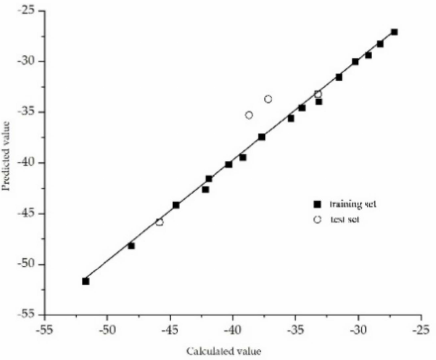
Figure 5. Correlation of the calculated and predicted values of plant–microbial synergistic degrada- tion effects of QNs in the CoMSIA